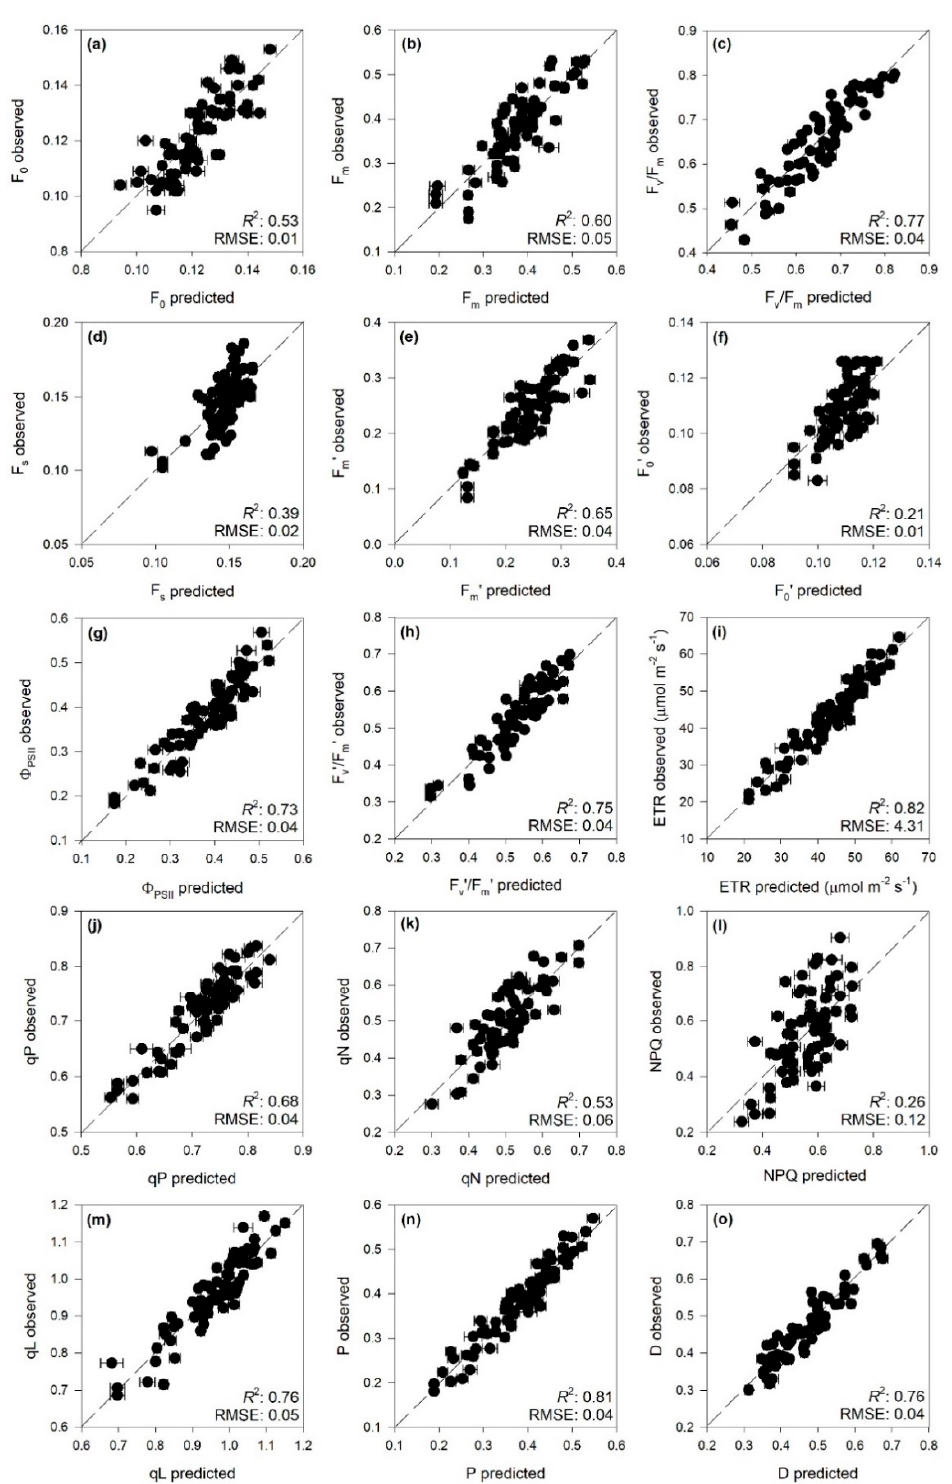
Figure 1. Observed vs. partial least squares regression (PLSR)-predicted values of chlorophyll a fluorescence parameters in date palm leaves; error bars for predicted values represent the standard deviation generated from 500 simulated models; dashed line is 1:1 relationship; model goodness-fit ( R 2 ), and root mean square error (RMSE) for validation data generated using 80% of the data for calibration and 20% for validation are reported. Bias outputs are not shown as they were always lower than 0.01. ( a ) F 0 ; ( b ) F m ; ( c ) F v /F m ; ( d ) F s ; ( e ) F m ’; ( f ) F 0 ′ ; ( g ) Φ PSII ; ( h ) F v ’/F m ’; ( i ) ETR; ( j ) qP; ( k ) qN; ( l ) NPQ; ( m ) qL ; ( n ) P; ( o ) D. See Table 1 caption for the parameter abbreviations.